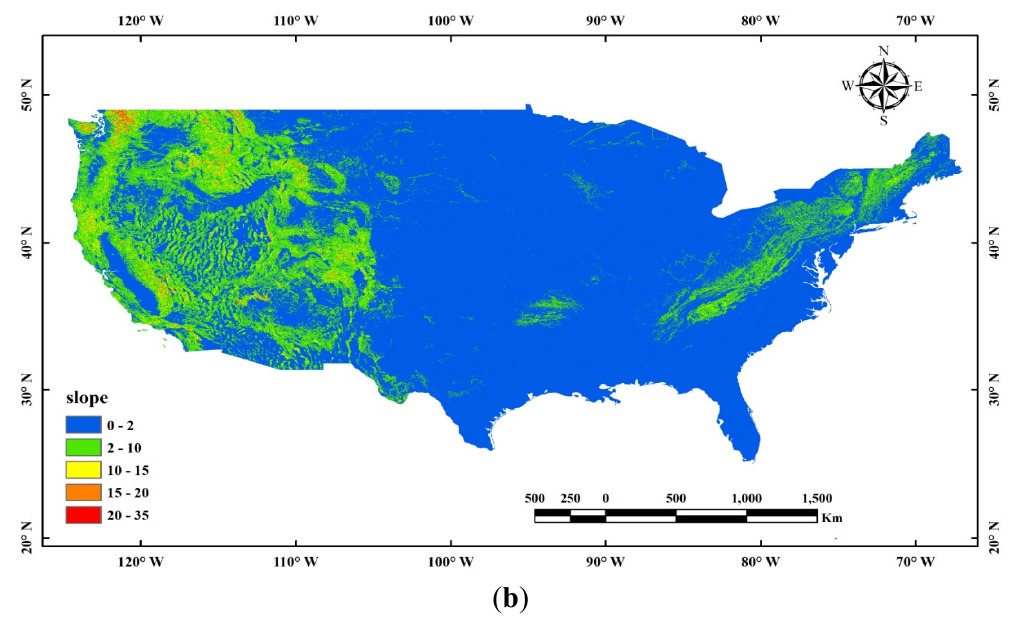
Figure 7. ( a ) The U.S. topographic map of altitude (1 km spatial resolution) ( b ) the U.S. topographic map of the slope classification (1 km spatial resolution). Table 3. (cid:1834)(cid:1870) values for the different elevation ranges over the United States. DEM (m) Classification Count Mean Hr <200 Plain 1080